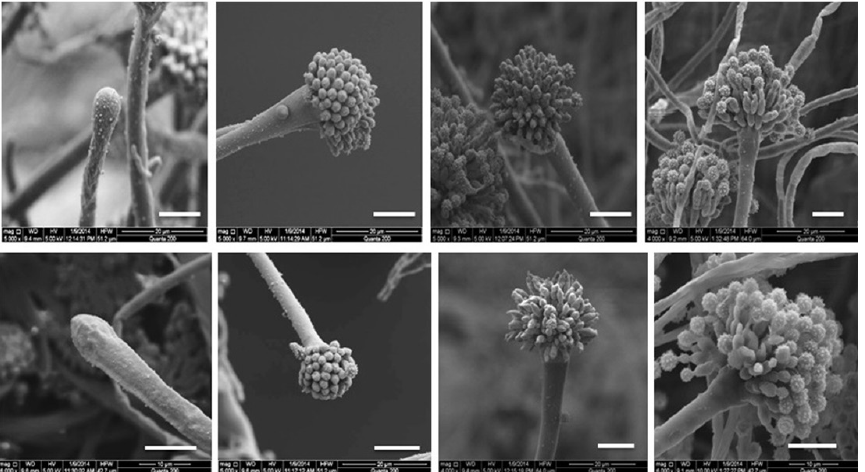
Fig. 4. Scanning electron micrographs of Aspergillus versicolor . The top row shows the formation of conidiophore and conidial head on MEA medium. The bottom row shows the formation of conidiophore and conidial head on YES agar medium (Bars = 10 µ